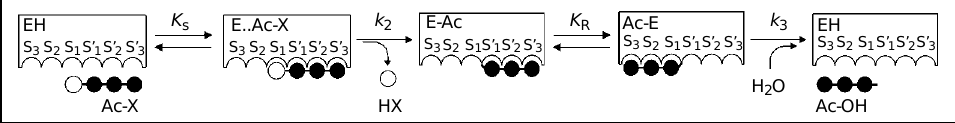
Figure 4 - Scheme of the extended kinetic model of a protease-catalyzed hydrolysis of substrate mimetics introducing the novel rearrangement equilibrium constant K R (25). EH, Free enzyme; Ac-X, substrate; [E..Ac-X], Michaelis-Menten complex; HX, leaving group; E-Ac, acyl enzyme intermediate bearing the acyl residue at the S’- subsite; Ac-E, acyl enzyme intermediate bearing the acyl residue at the S-subsite; Ac-OH, hydrolysis